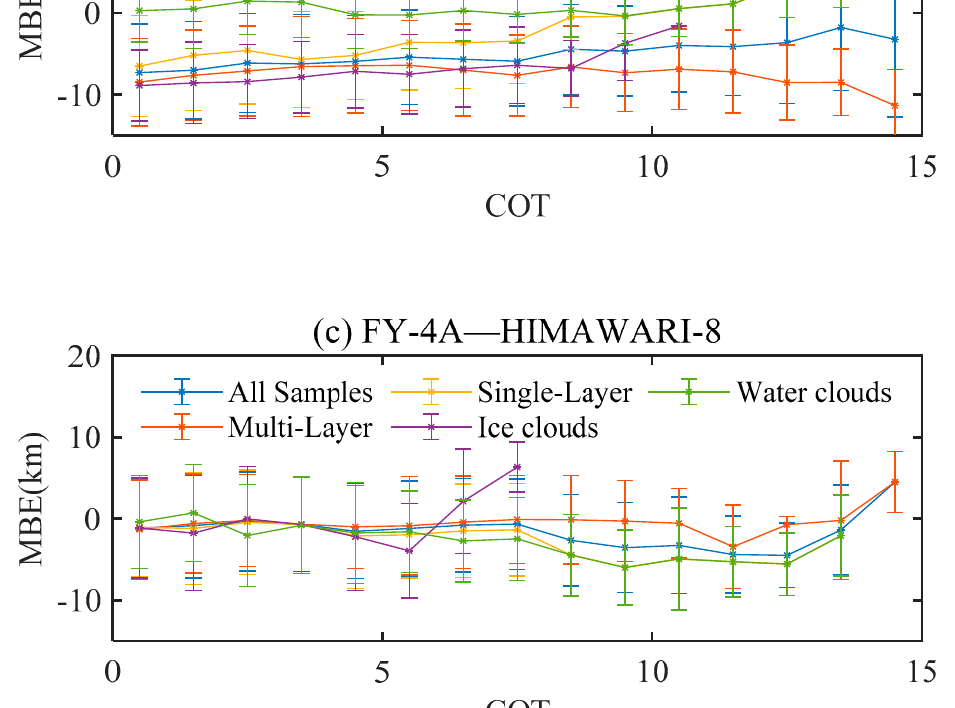
Figure 3. The variation of MBE with COT for all samples, multi-layer clouds, single-layer clouds, ice clouds and water clouds of different satellites. The error bars represent STD. ( a ) FY-4A–CALIPSO ( b ) HIMAWARI-8–CALIPSO ( c ) FY-4A–HIMAWARI-8. The variation between MBE with CTH among all samples, multi-layer clouds, single- layer clouds, ice clouds and water clouds of different satellites is shown in Figure 4. It can